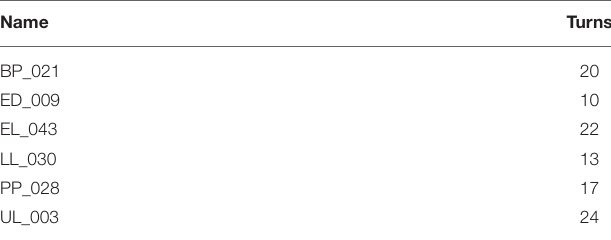
TABLE 3 | Number of turns per individual (emoji